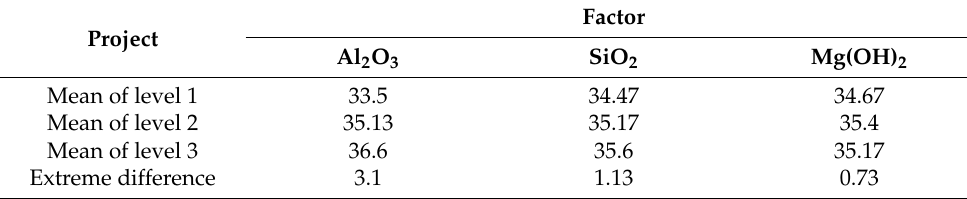
Table 6. Mean and extreme difference analysis of the breakdown voltage of each factor